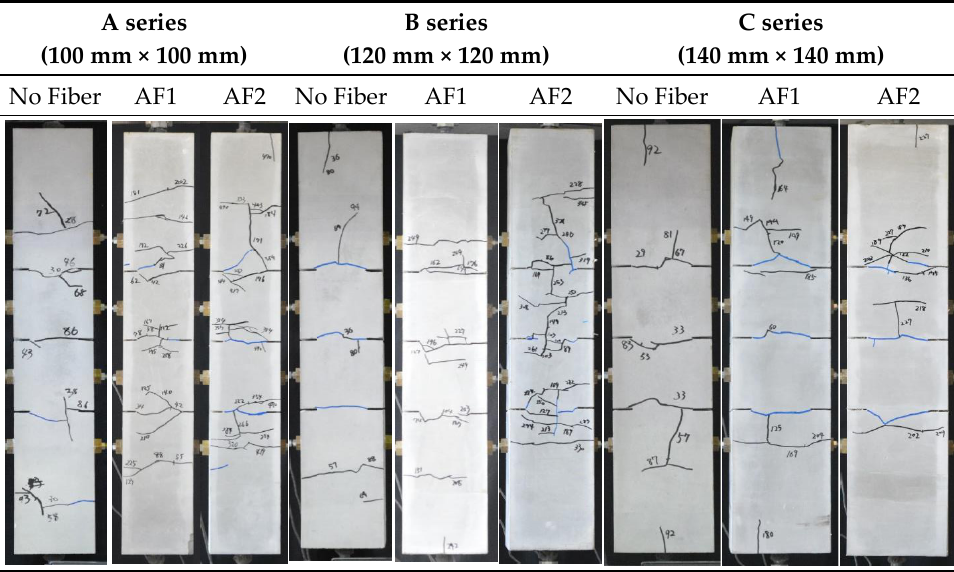
Figure 11. Examples of crack patterns after steel rebar yielding [24].